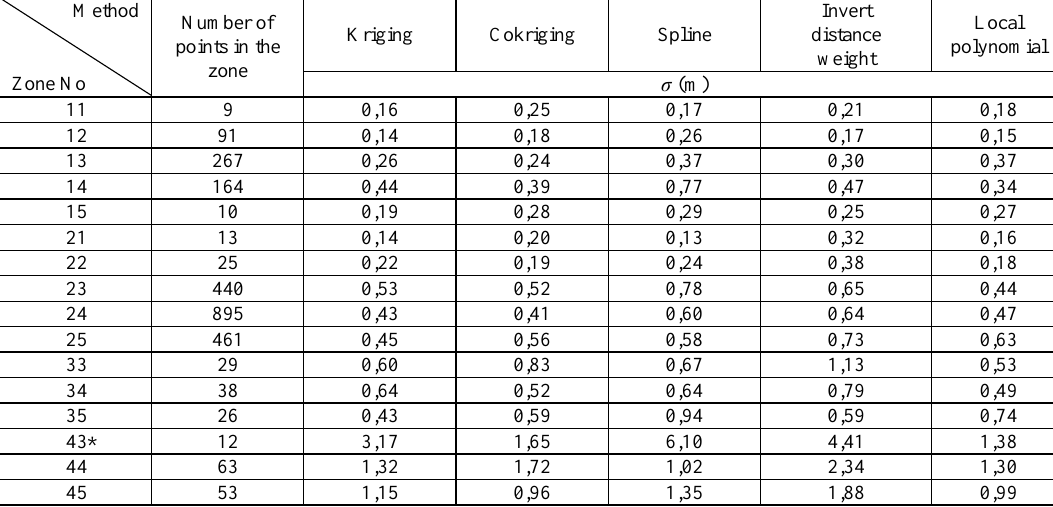
Table 6. Standard deviations of DEM in different